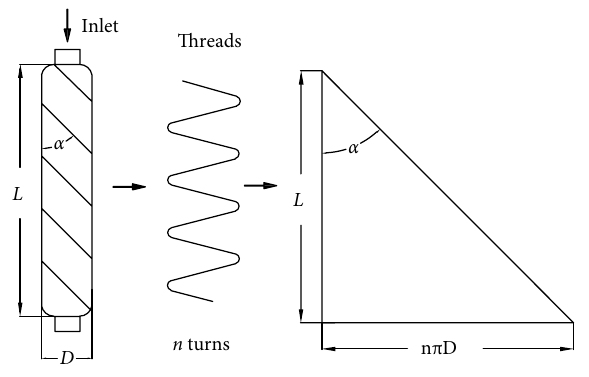
Figure 1: Geometry of